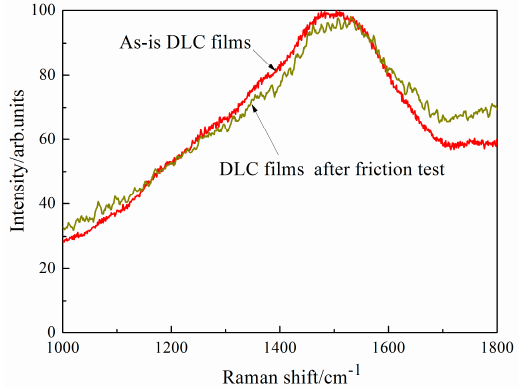
Figure 12. Raman spectra of DLC films before and after friction test.